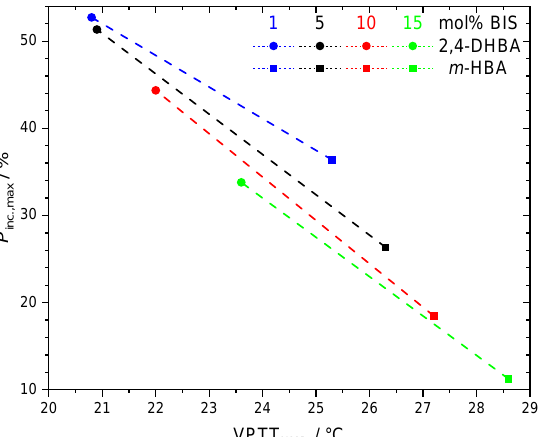
Figure 6. Maximum of incorporated species P inc,max as a function of the transition temperature VPTT NMR for 2,4-DHBA (circles) and m -HBA (squares) for different crosslinker contents (blue x = 1, black x = 5, red x = 10, green x = 15). Dashed lines are guide to the eye and connect polymers of the same crosslinker content.